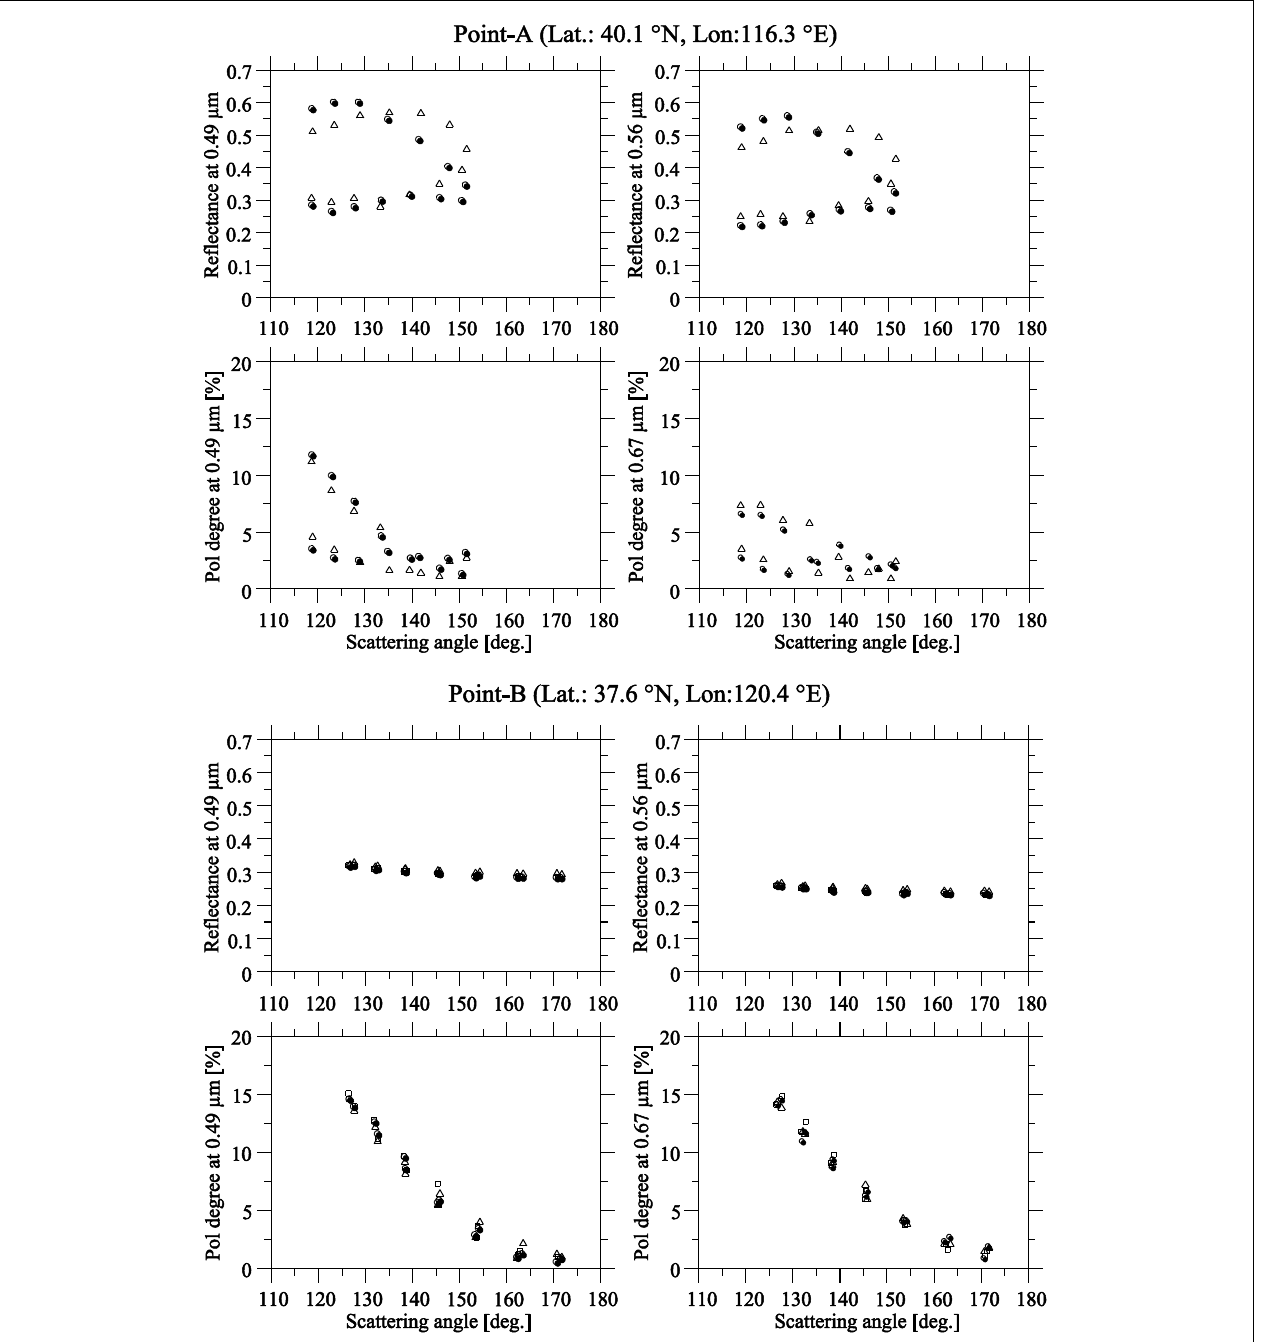
FIGURE 7 | Reflectance and degree of polarization observed by PARASOL/POLDER at wavelengths of 0.49, 0.56 (only reflectance), and 0.67 µ m (only polarization) at the observing points-A and B on 21st June 2012. Different symbols indicate nearby pixels.